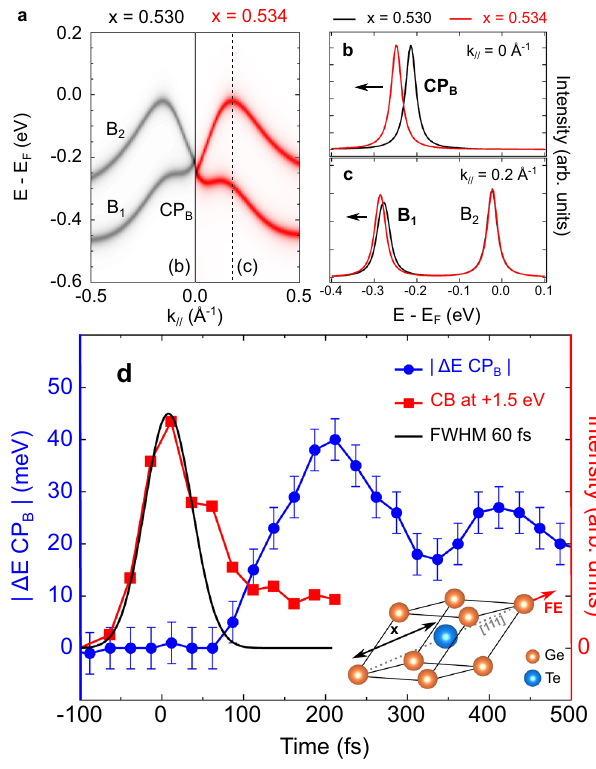
Fig. 3 | Band structure calculation and temporal evolution of CP B position. a Bulk band structure of α -GeTe(111) along the (cid:1) Γ (cid:1) (cid:1) K high-symmetry direction for two different x positions of the Te atom, as de fi ned in the inset of panel d . Corre- sponding EDCs for x =0.530 (black) and x =0.534 (red) taken at b k =0.0 Å − 1 and c k =0.2 Å − 1 . d Temporal evolution of CP B extracted from tr-ARPES measurements taken at an absorbed pump fl uence of 1.5mJ/cm 2 (blue curve; the error bars have been extracted from the fi tting procedure). The red curve corresponds to the transient population of the conduction band and the black curve to the corre- sponding Gaussian fi